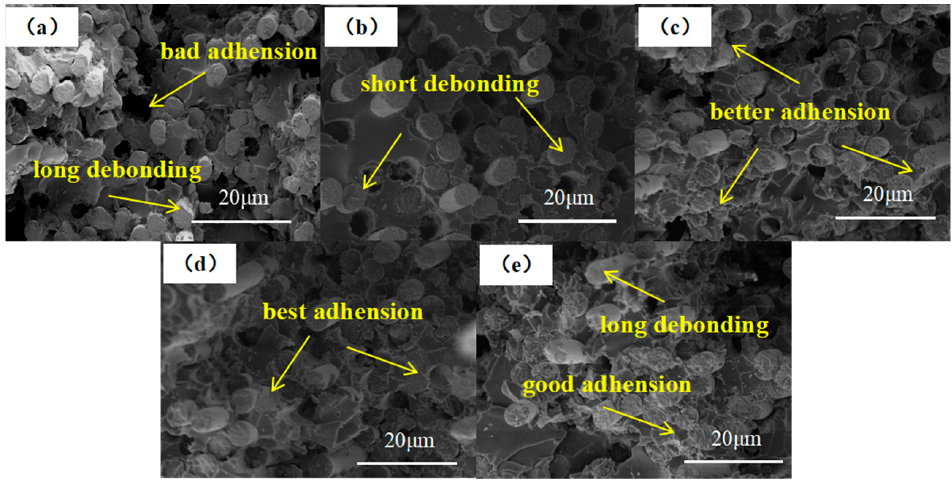
Figure 10. Morphology of the impact fracture of composites: ( a ) CF-COOH; ( b ) MOF/CF-5; ( c ) MOF/CF-7; ( d ) MOF/CF-9; ( e ) MOF/CF-11.